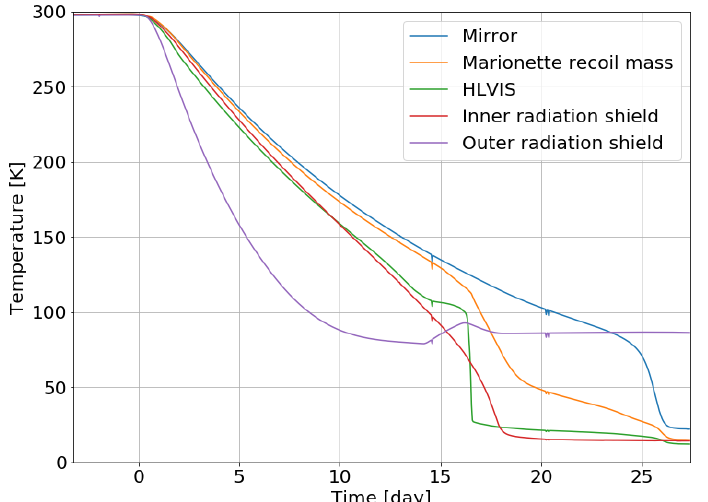
Figure 8. Example of the cooling curves of KAGRA’s cryogenic system. The mirror reached 22 K at 27 days after the start of cooling. The cooling speed drastically changed below 100 K because of the increase in the thermal conductivity of the heat links and decrease in the specific heat. Each component is shown in Figure